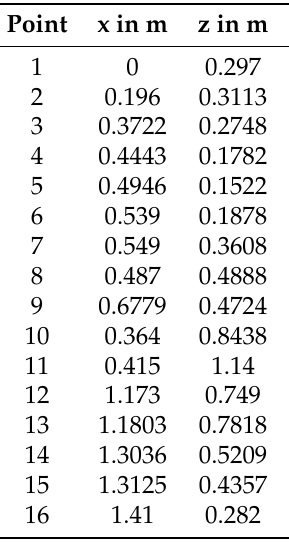
Figure A1. Scheme for the geometric parameters. Table A1. Dimensions.